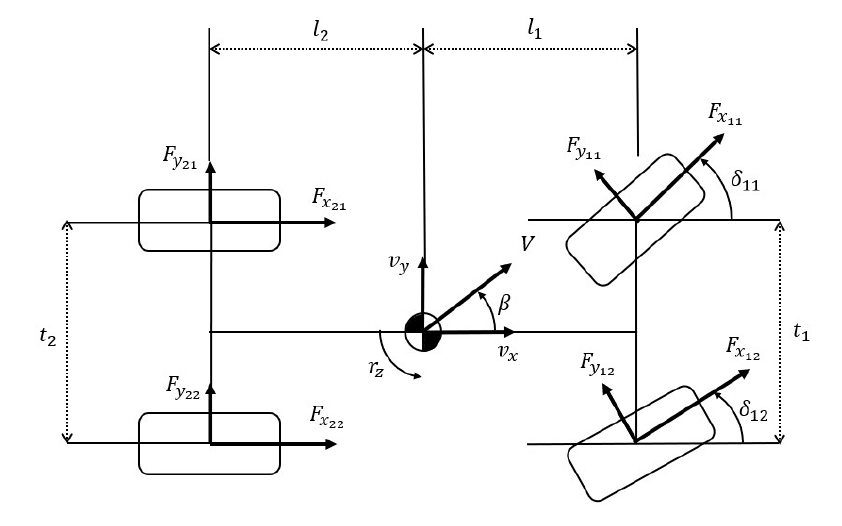
Figure 2. Typical simplified vehicle model